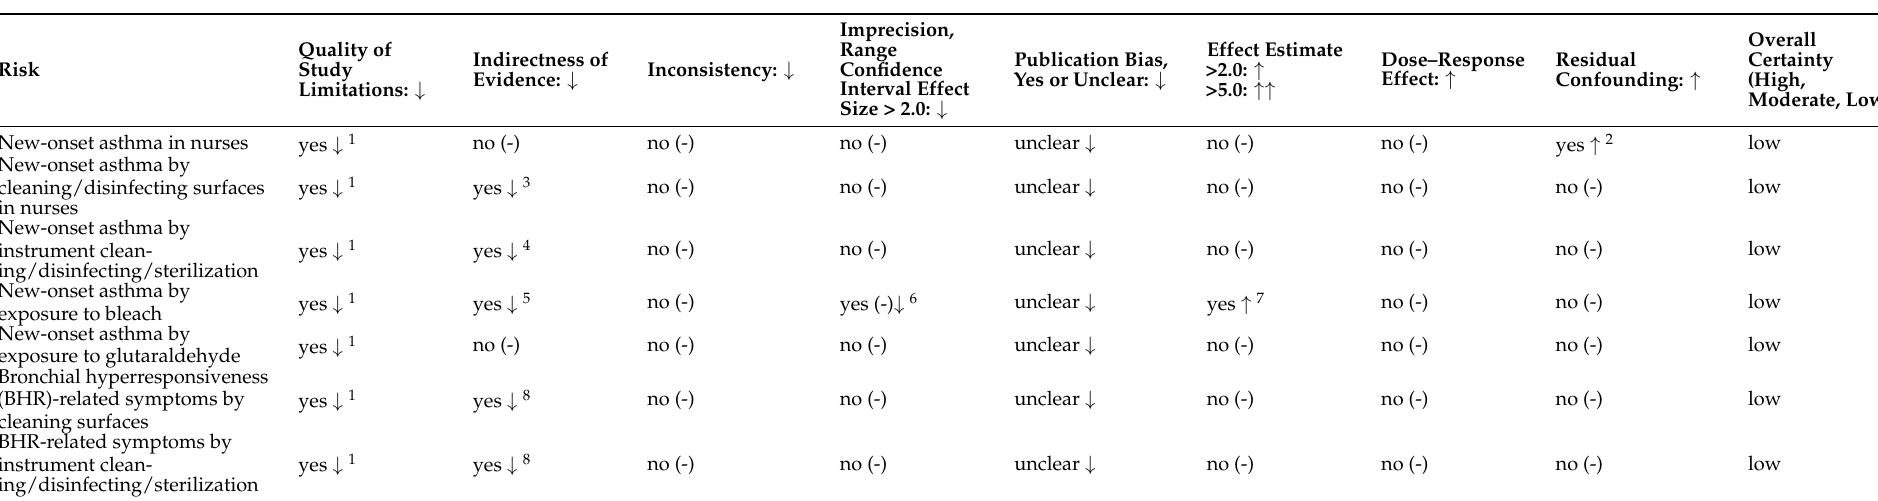
Table 4. Assessment of evidence for the risk of studied outcomes based on Grading of Recommendations, Assessment, Development, and Evaluation (GRADE) framework. Quality of Risk